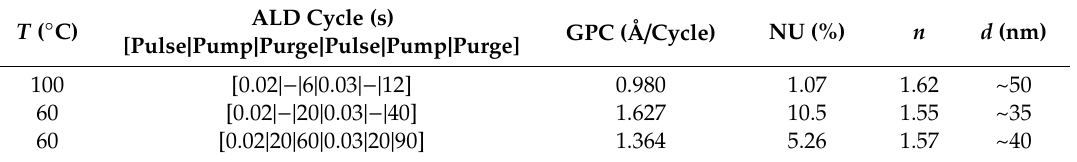
Table 1. Atomic layer deposition (ALD) process parameters of thermal Al 2 O 3 and characterizations.